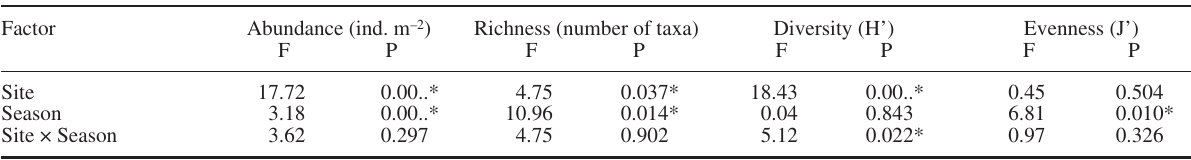
Table 5. – Caswell V statistics for impacted sites (I) and non- impacted sites (NI) in each sampling season.